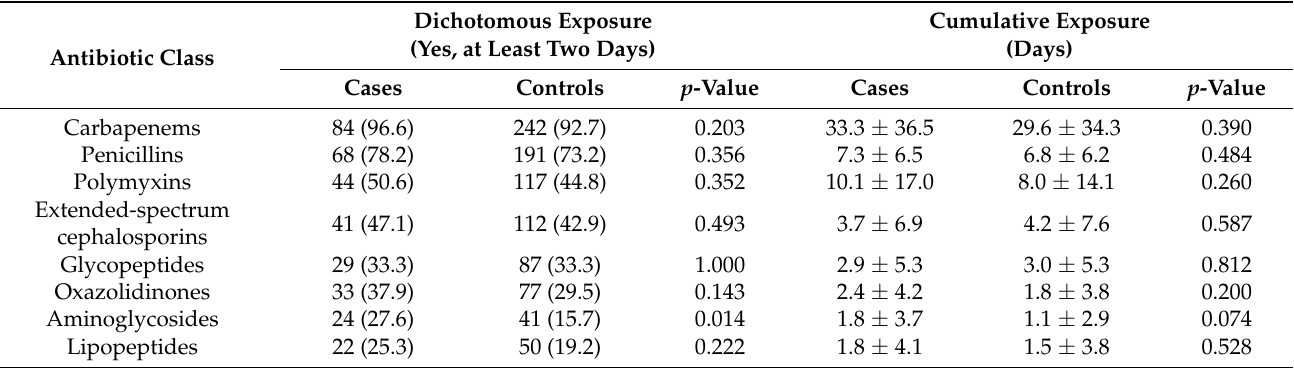
Table 2. Prior antibiotic exposure expressed as dichotomous (number, percentage) or cumulative (in days, mean ± standard deviation) comparing cases and controls. Cumulative exposure reports the mean days of antibiotic use for each group, considering both exposed and unexposed patients.